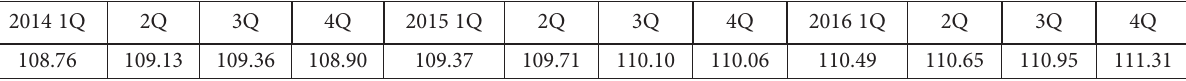
Table 4. Consumer Price Index by the year (2010 = 100) (source: Korean Statistical Information Service,